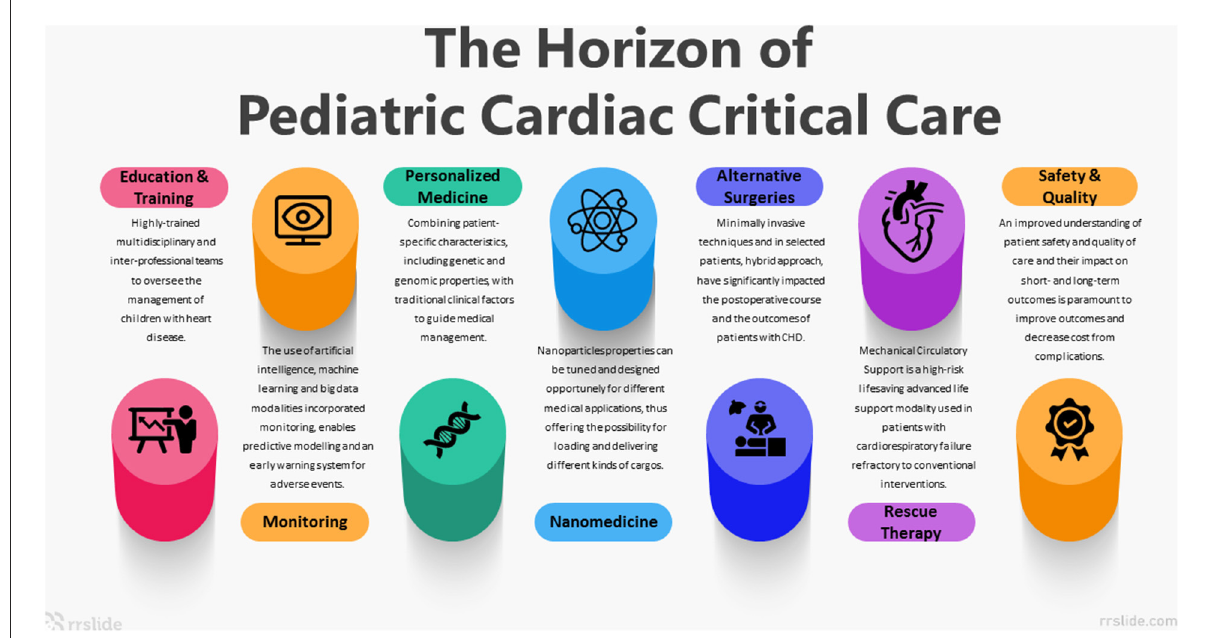
FIGURE1 Seven Pediatric Cardiac Critical Care key elements that will pave the way to the coming